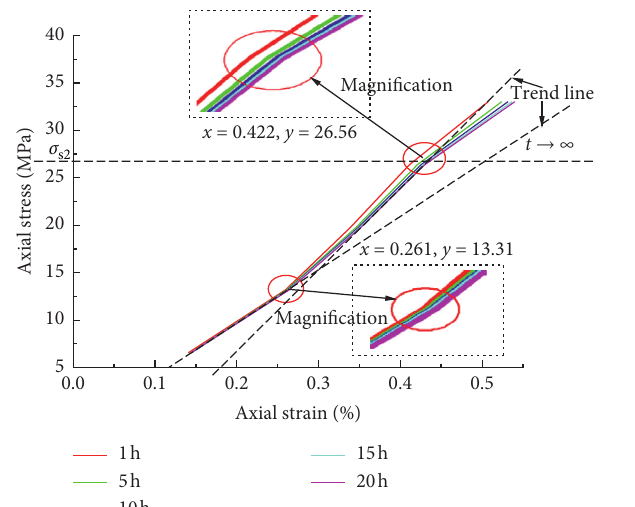
Figure 12: Families of isochronous stress-strain curves of rock-concrete composite specimens under the confining pressure of 7MPa.